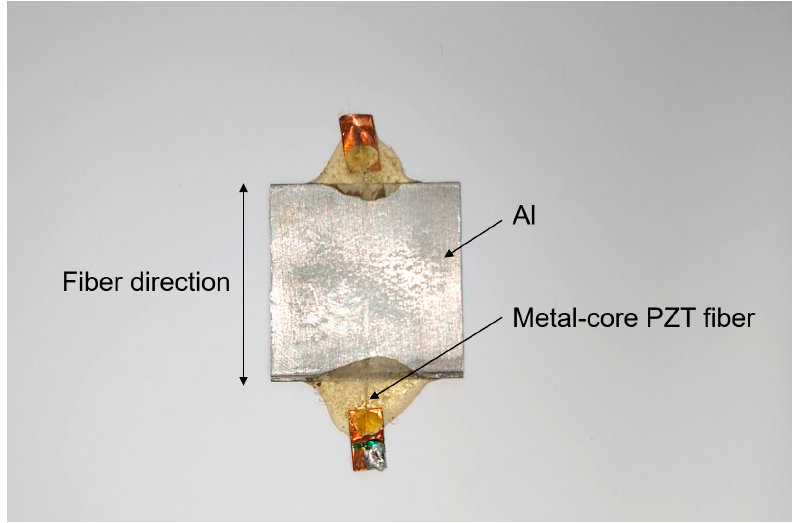
Figure 11. Metal-core lead zirconate titanate (PZT) piezoelectric fiber/Al composite sample.